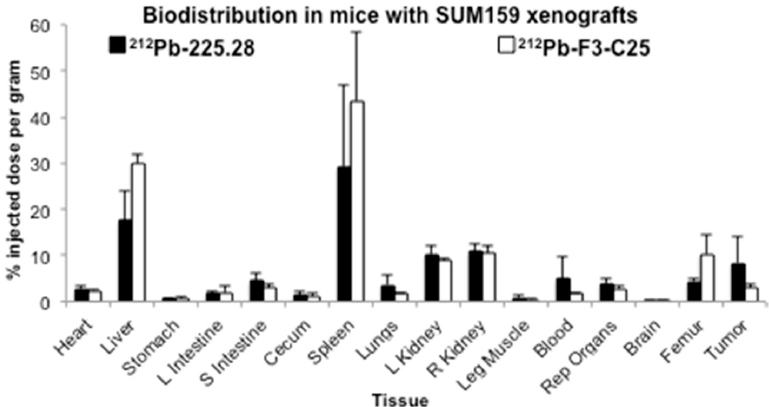
Figure 1. Biodistribution results at 24 h after i.v. injection of 0.78 MBq 212 Pb-225.28 or 212 Pb-F3-C25 in groups of athymic nude mice ( n = 4/group) bearing small SUM159 xenografts implanted in the mammary fat pad. Data are presented as mean % ID/g ± standard deviation, and the difference in the tumor uptake between the two groups was analyzed by Student’s t -test (not significant).